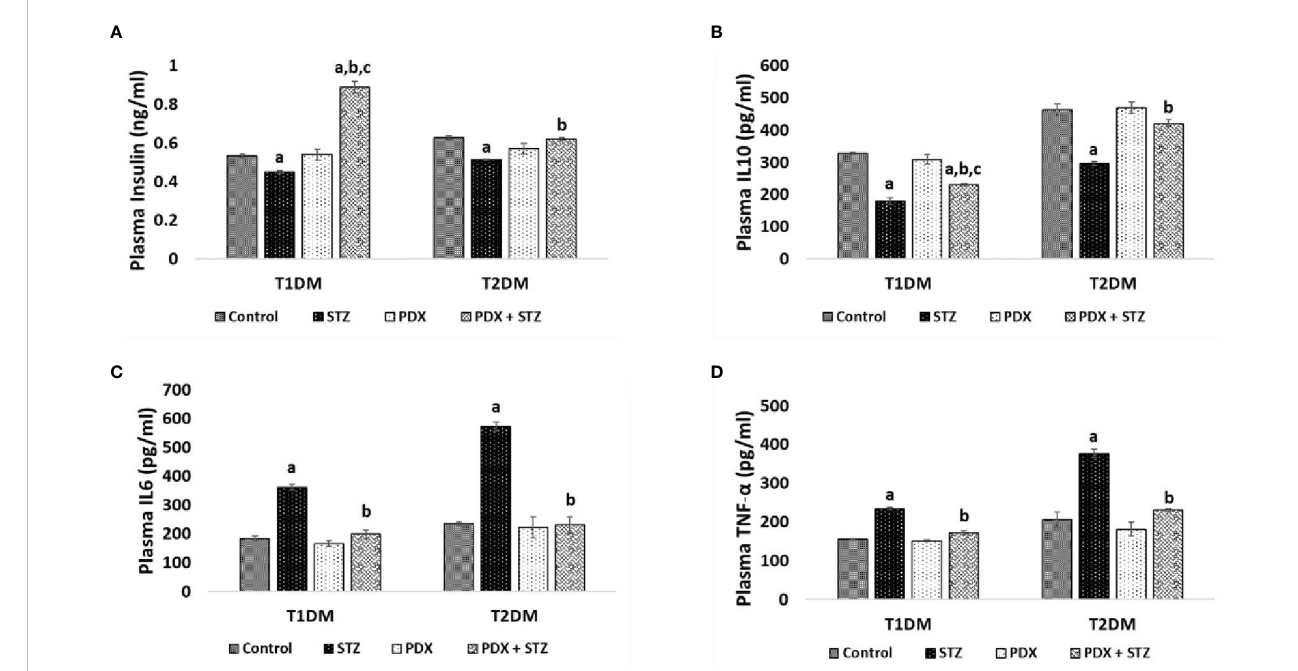
FIGURE 3 ELISA estimations in mice plasma. Insulin (A) , IL10 (B) , IL6 (C) , TNF- a (D) were estimated in Type 1 DM and Type 2 DM mice plasma using ELISA. All values are expressed in mean + SEM. N=6. a,b,c p < 0.05 compared to control, STZ and PDX respectively. STZ – Streptozotocin, PDX – 10(S),17(S)-